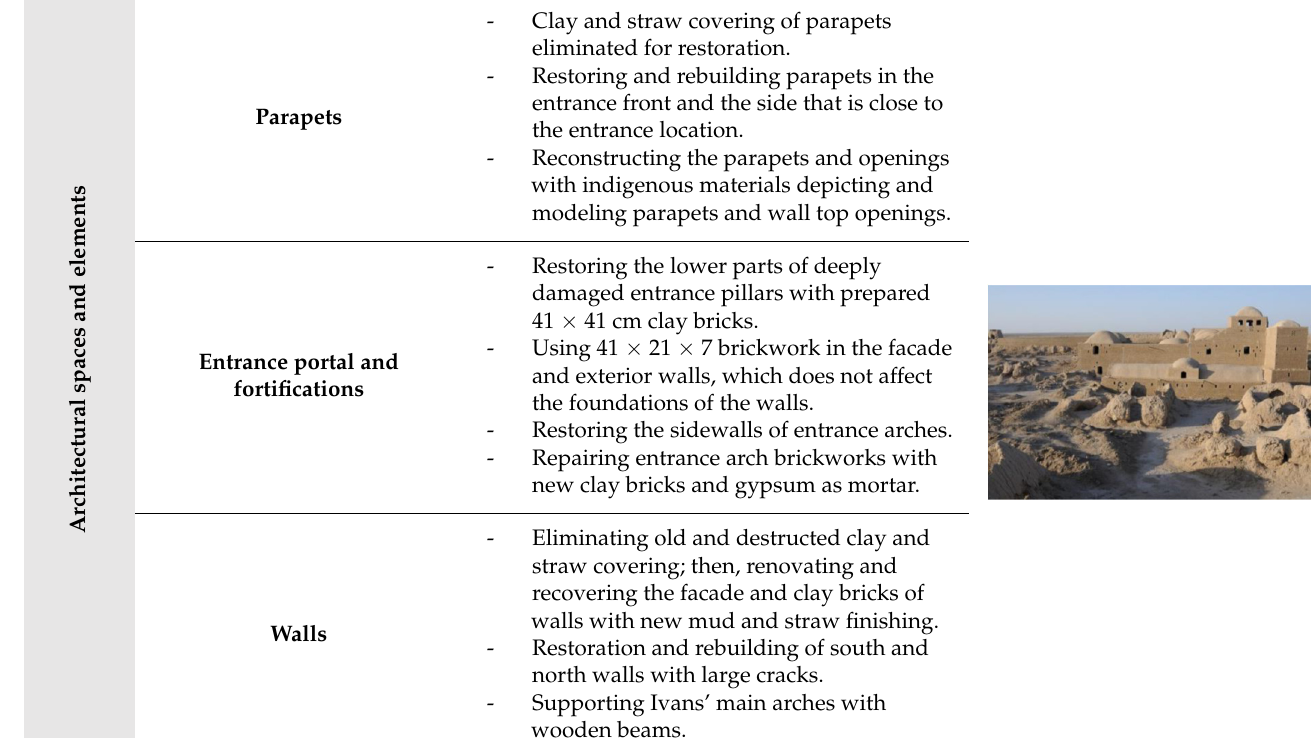
Table 4. Exterior and visual features (Rostam Castle).